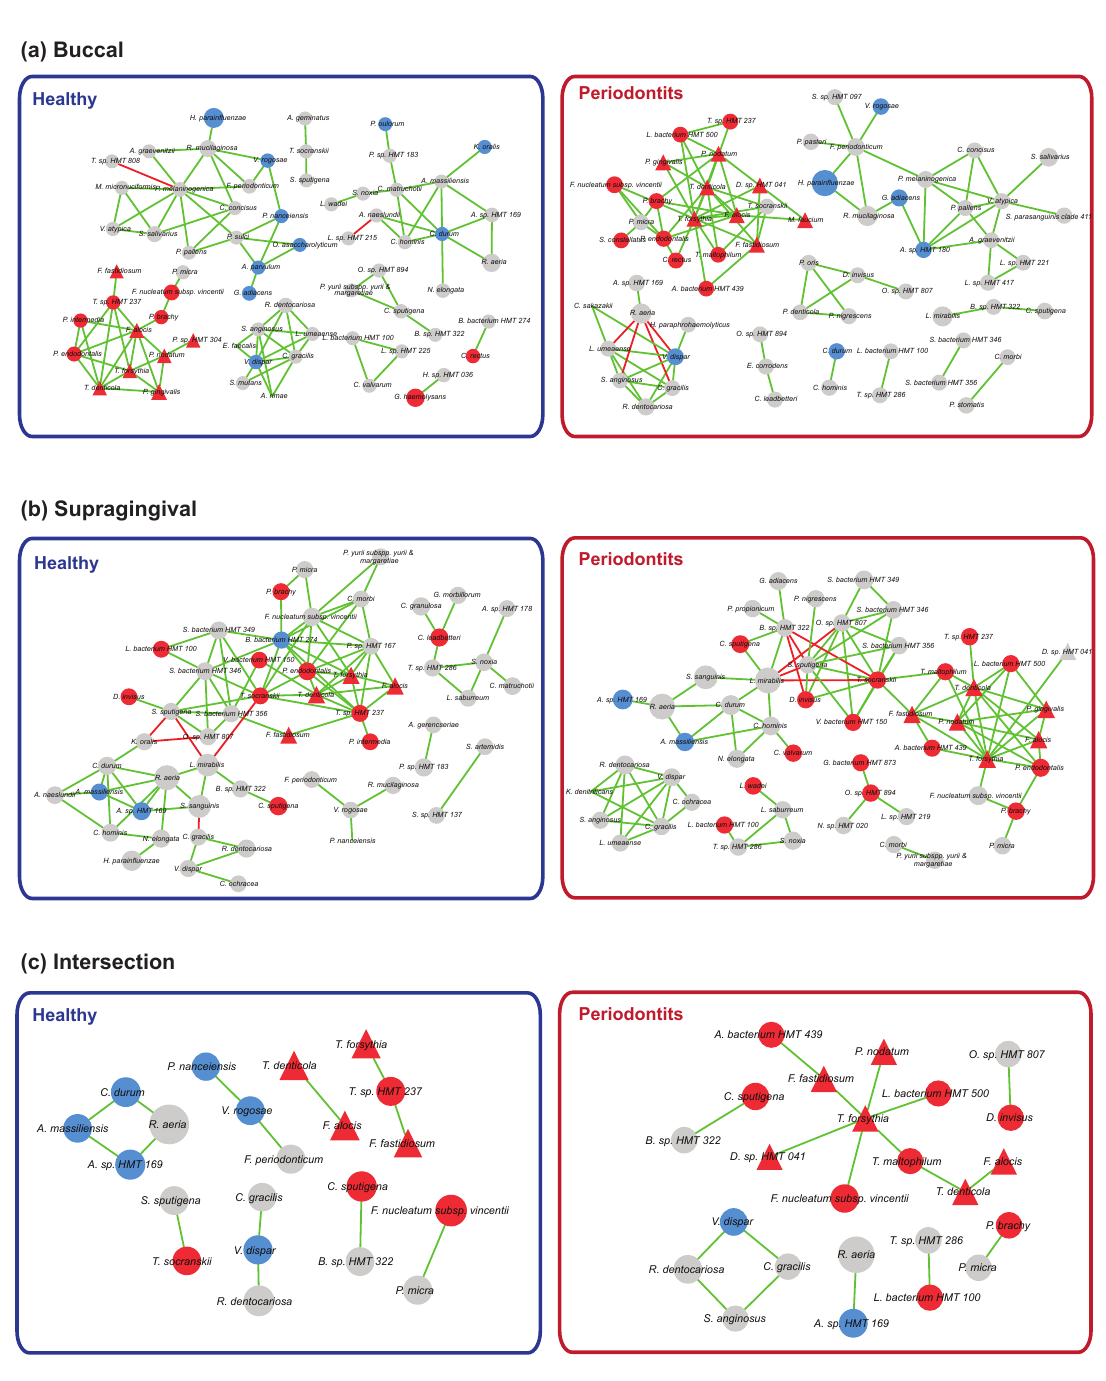
Figure 6. Bacterial community interaction network analysis. The co-occurrence bacterial community networkswereconstructedusingSparCCmethodandvisualizedinCytoscapesoftware. Theintersection networks between two networks between buccal and supragingival sites were obtained using Cytoscape merge tools. ( a ) Interaction networks in buccal site, ( b ) interaction networks in supragingival site, and ( c ) intersection networks in the H and periodontitis groups. Diamond shape node represents the highly correlated bacterial species with clinical parameters. The di ff erential bacterial species between healthy and periodontitis groups were colored as blue (healthy) or red (periodontitis). The directions of the correlation between two bacterial species were annotated as edge colors; red color: negative correlation, green color: positive